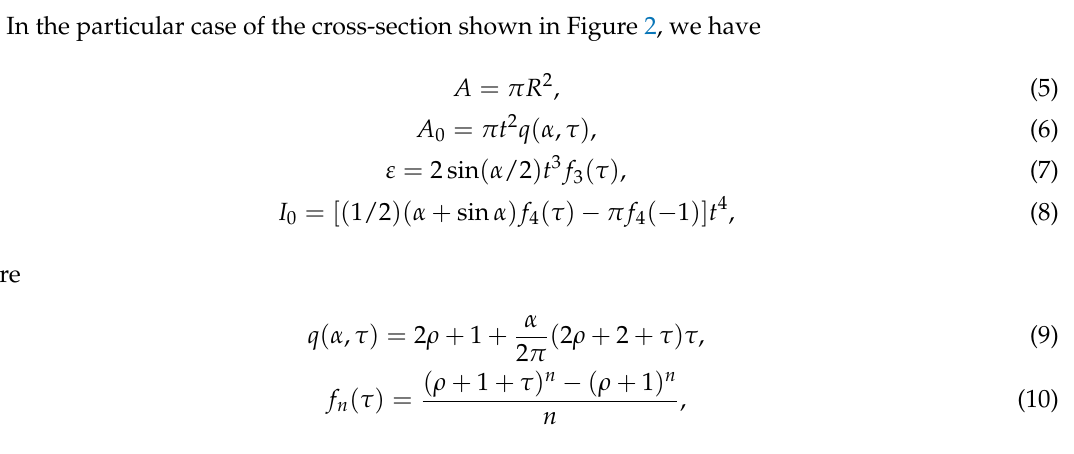
Figure 2. Cross-section of pneumatic actuator made of hollow polymer tube of radius R and thickness t and polymer patch of angular width α and thickness T on top of